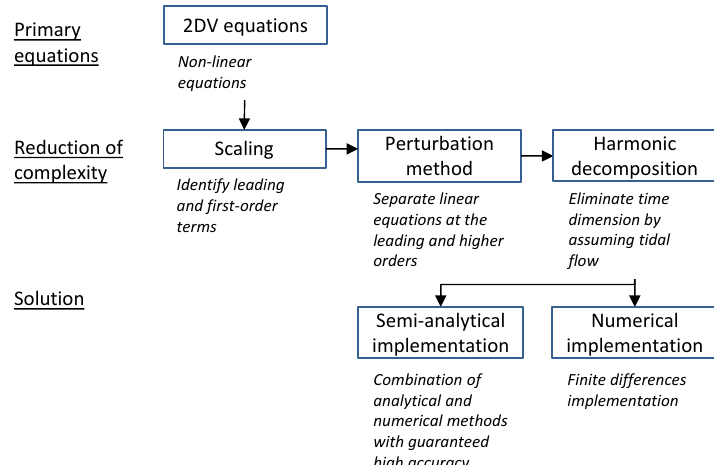
Figure 3. Flow diagram outlining the main steps taken in the derivation of the implemented equations for hydrodynamics and sediment dynamics. The fully non-linear width-averaged equations are taken through several steps of analysis to reduce the complexity of the system. Then, two implementations of this reduced system are made, each with their own advantages and